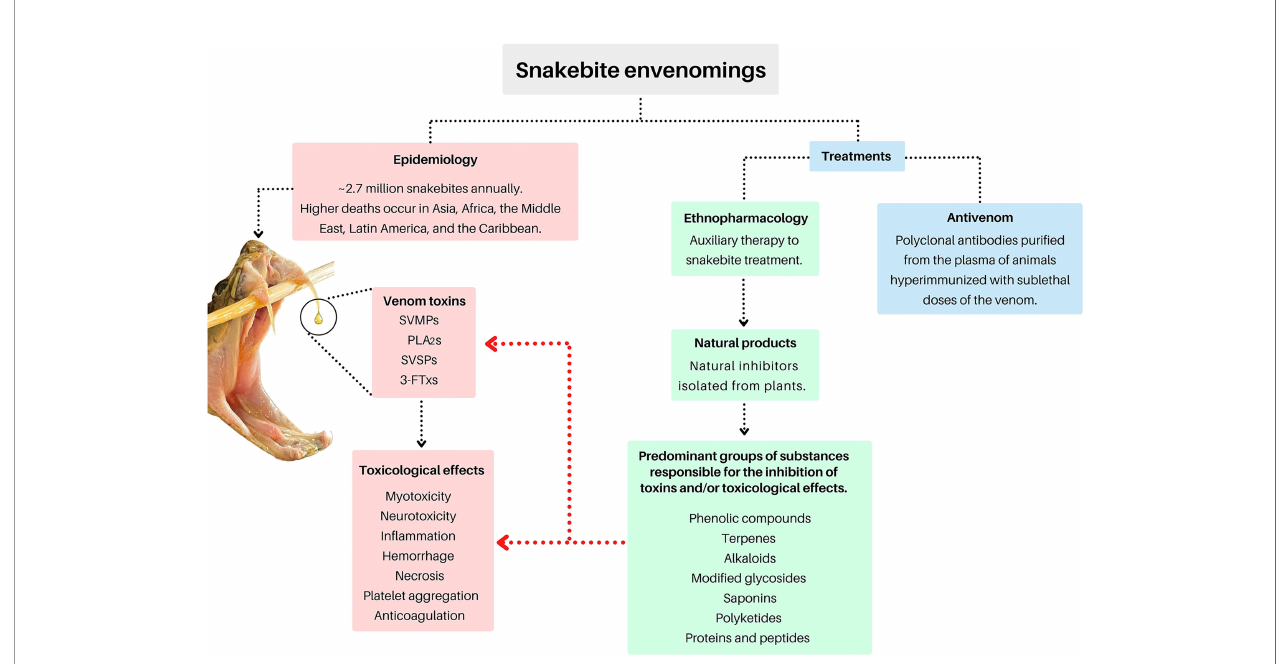
FIGURE 2 | Mind map of the topics covered in this review. Snake photo: Asenate A. X. Adrião. The fi nal fi gure was prepared using